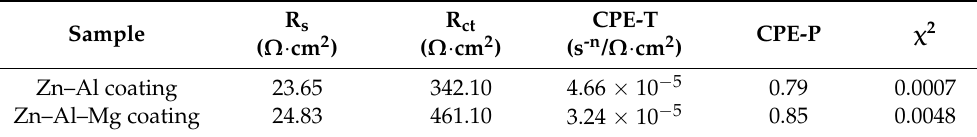
Figure 11. ( a ) Nyquist plot and ( b ) equivalent circuit used to fit the EIS data of the galvanized coating surface. Table 3. EIS equivalent fitting